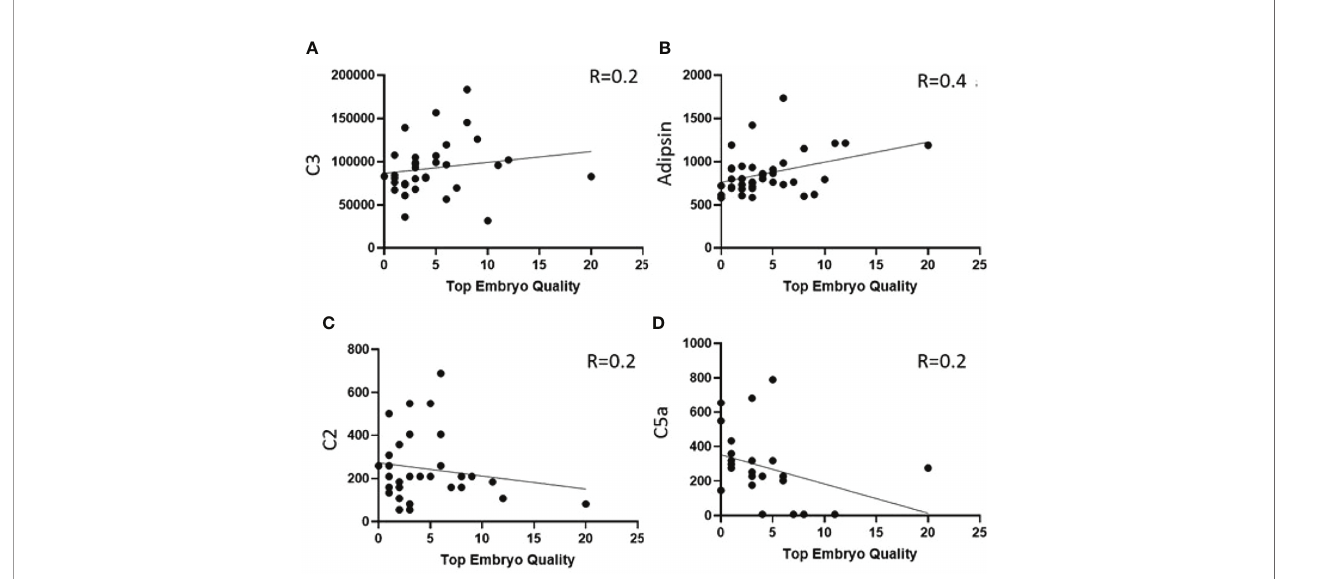
FIGURE 4 | Correlation between number of top-quality embryos and complement factors in pre-IVF serum. (A, B) Showing increased levels of C3 and Adipsin with high numbers of top embryo quality and (C, D) shows decreased levels of C2 and C5a with high numbers of top embryo